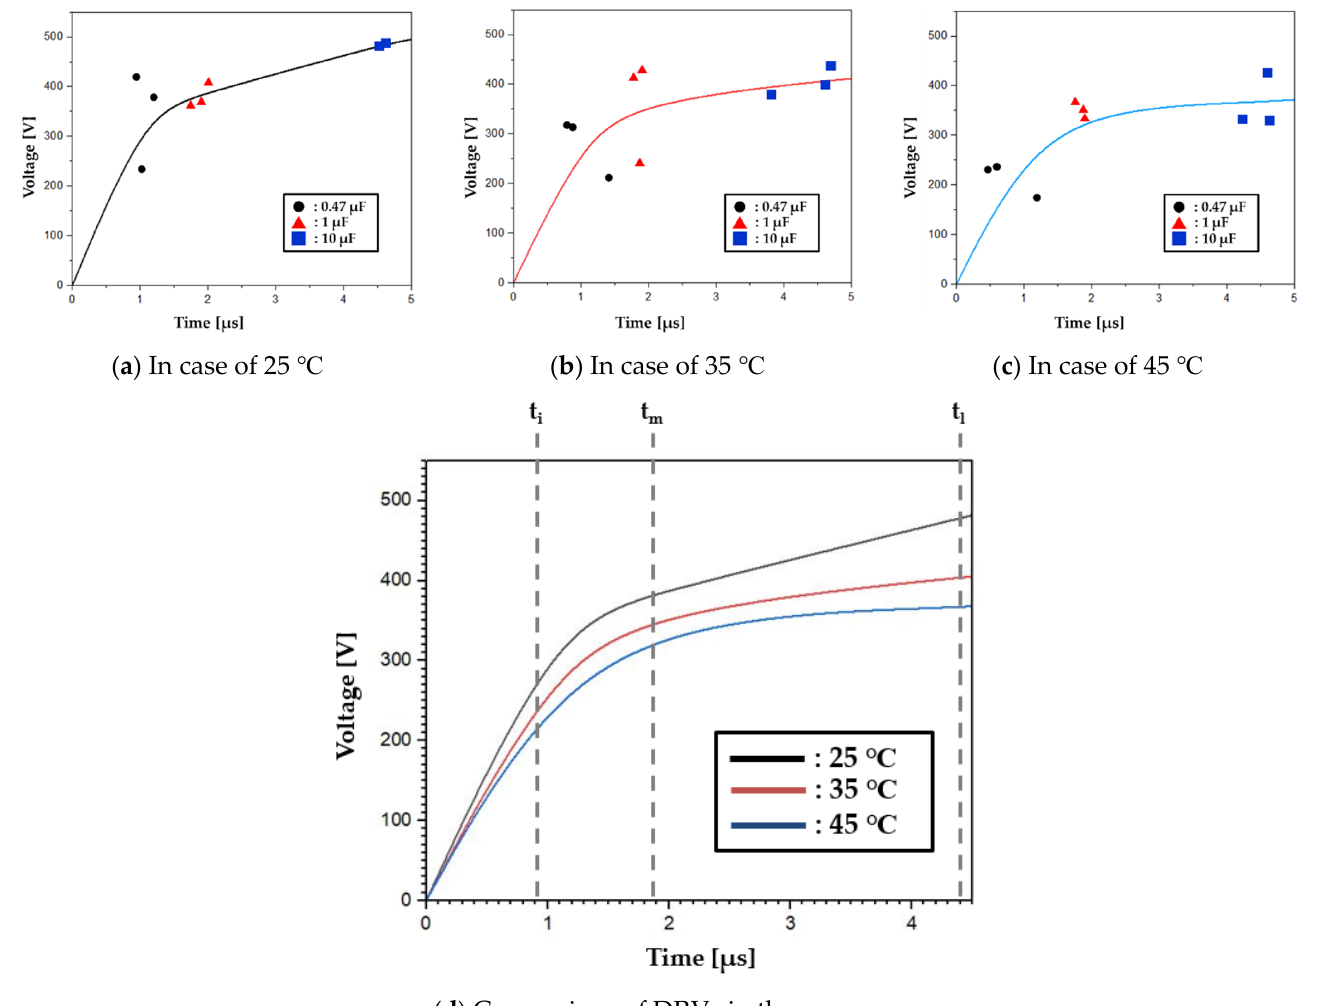
Figure 13. DRV V-t curve according to temperature.